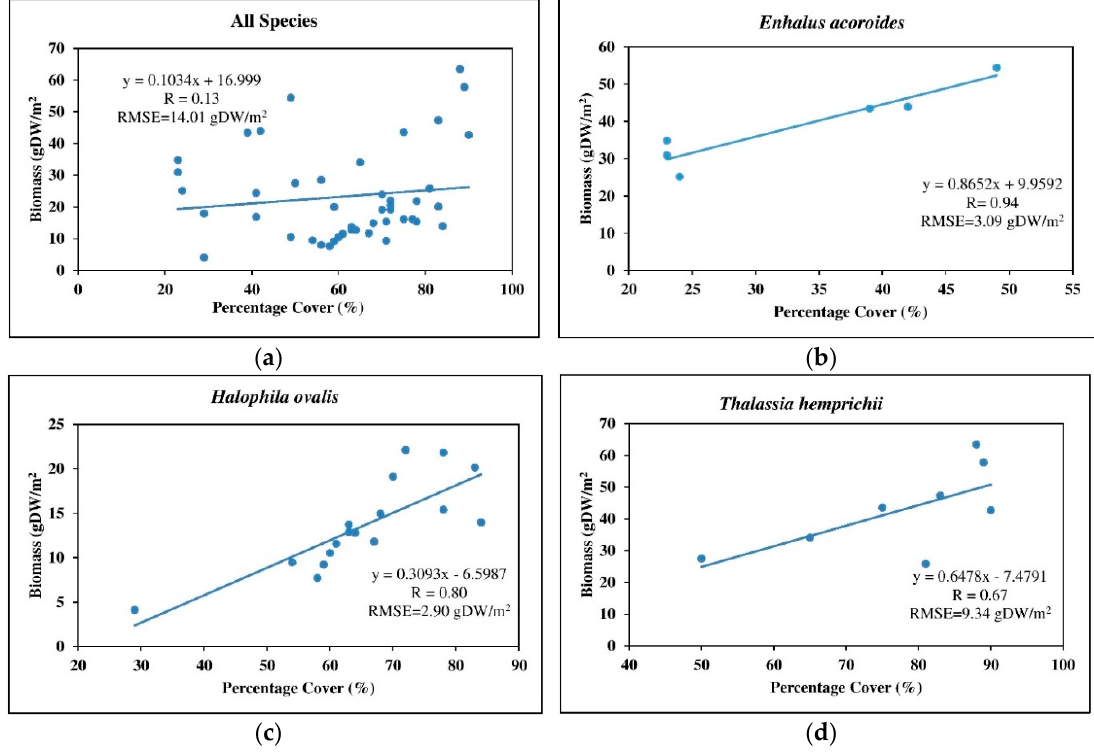
Figure 6. Plot of percentage cover vs. observed seagrass above=ground biomass (g·DW/m 2 ) using the simple linear regression model for ( a ) all species; ( b ) Enhalus acoroides ; ( c ) Halophila ovalis ; and ( d ) Thalassia hemprichii . The observed above-ground biomass values are based the field data gathered from 16 to 18 February 2014 in Paklok Bay.